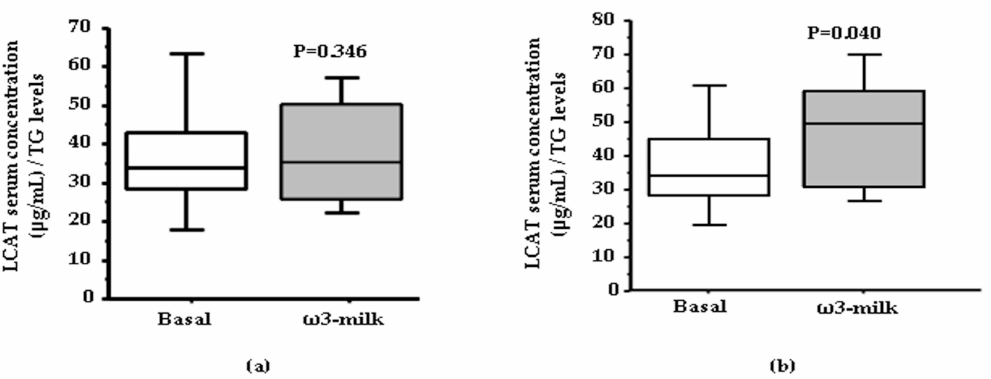
Figure 4. Changes on lecitin cholesterol acyltransferase (LCAT) serum levels after ω 3-milk intake. Box-Plot diagrams showing LCAT concentration ( µ g/mL) in basal conditions and after the intake of ω 3-milk, measured by a commercial ELISA. ( a ) No change was observed when all the volunteers were analyzed ( N = 32; p = 0.346). ( b ) There was a significant increase in LCAT serum levels in subjects that showed a reduction in TG levels after ω 3-milk intake ( N = 11; p = 0.0397).